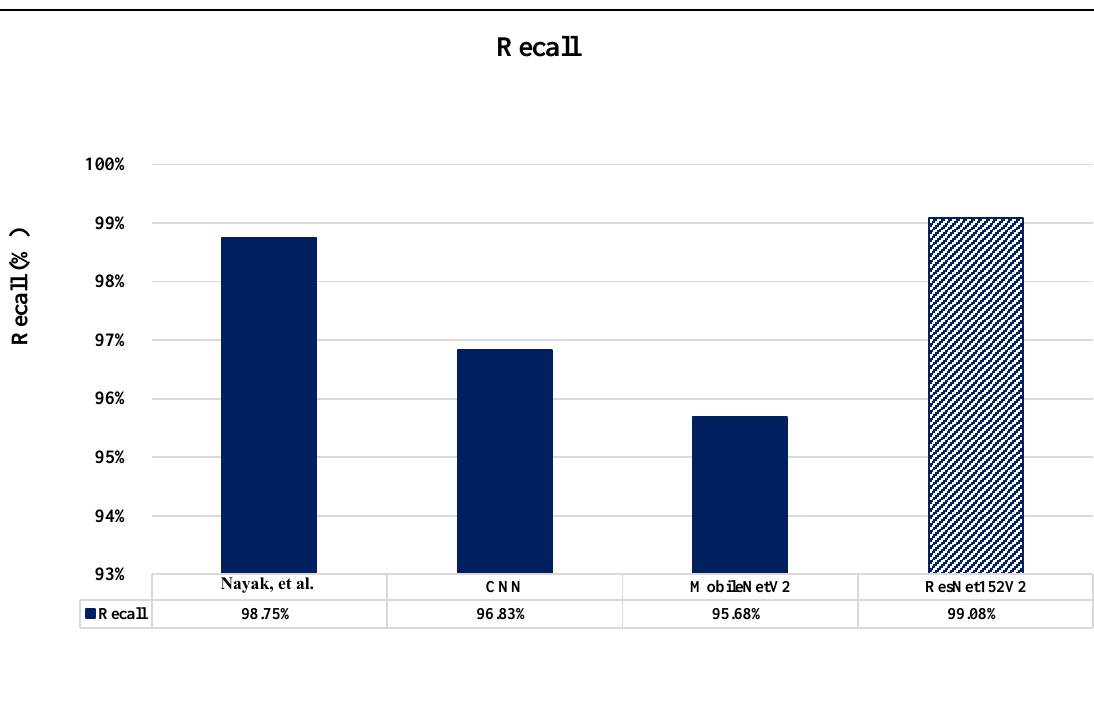
Figure 18. Recall performance metrics comparison between our proposed models and previous studies [18] .